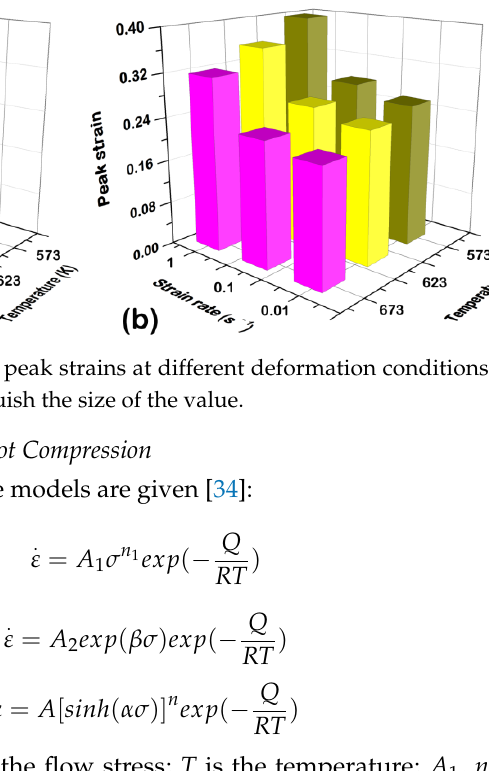
Figure 3. True compressive stress – strain curves at strain rates: ( a ) 0.01 s − 1 ; ( b ) 0.1 s − 1 ; ( c ) 1 s − 1 .